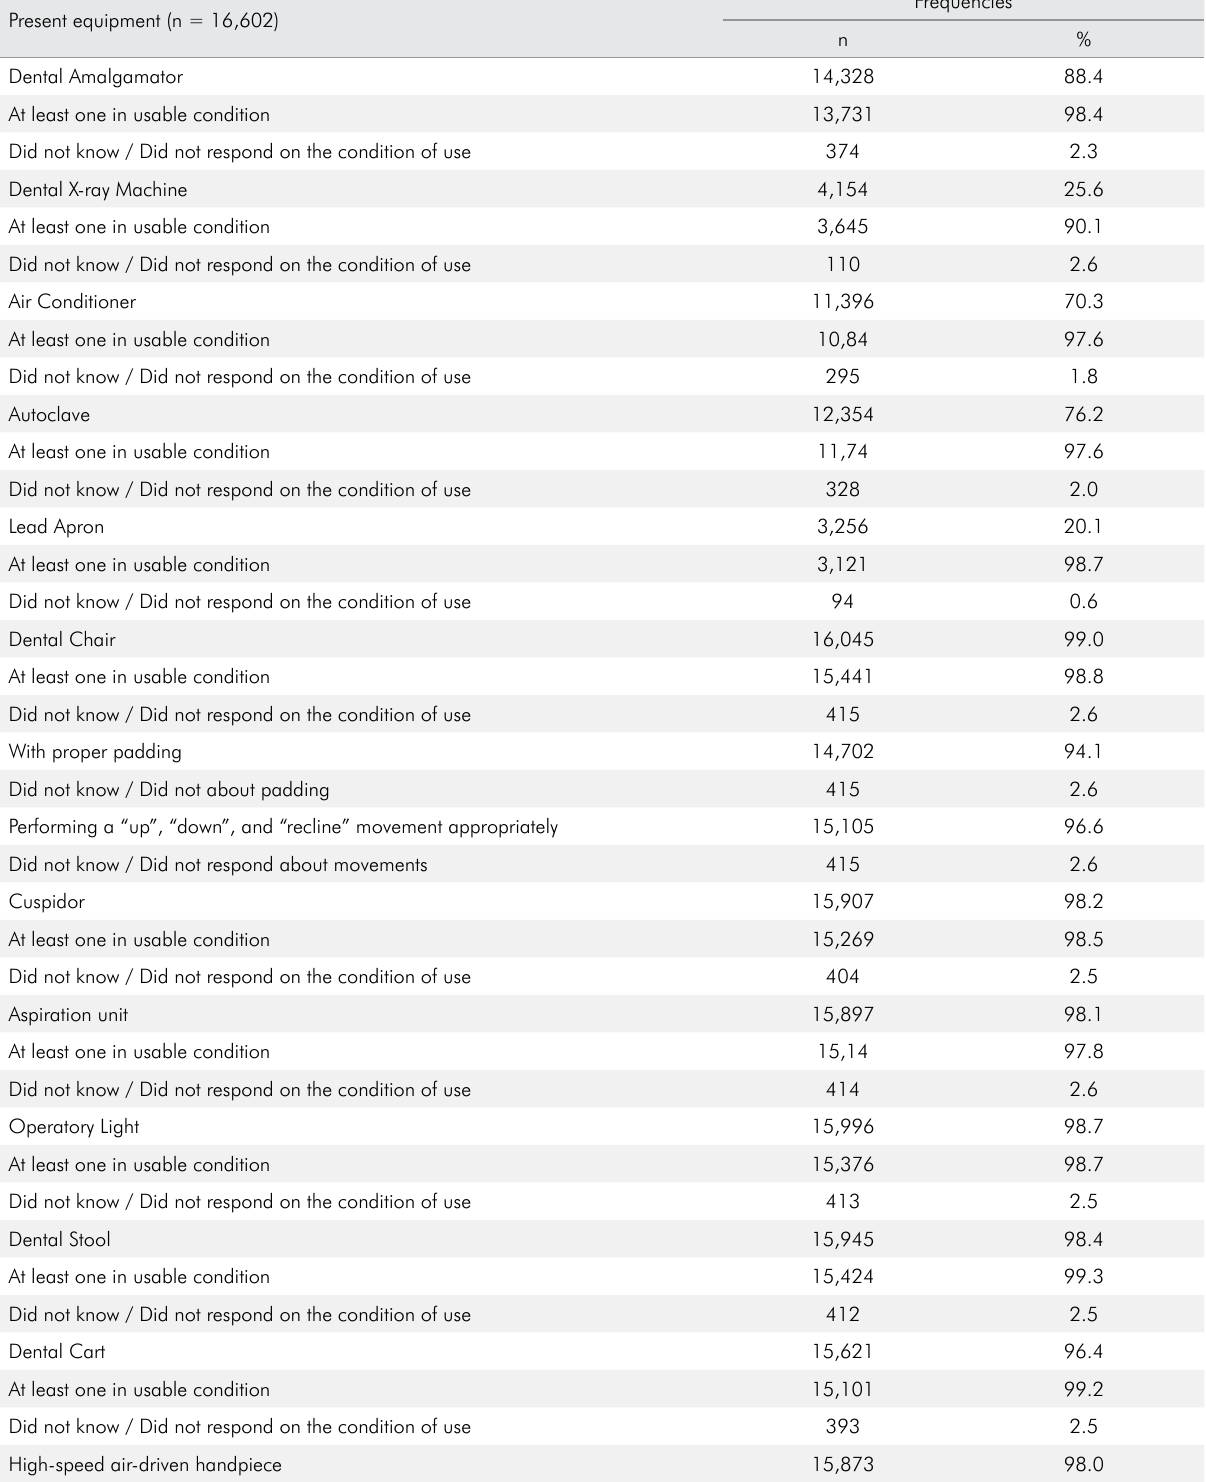
Table 1. Descriptive analysis of present dental equipment that met proper use conditions in the oral health services evaluated in this study. PMAQ-AB. Brazil, 2013-2014 (n =